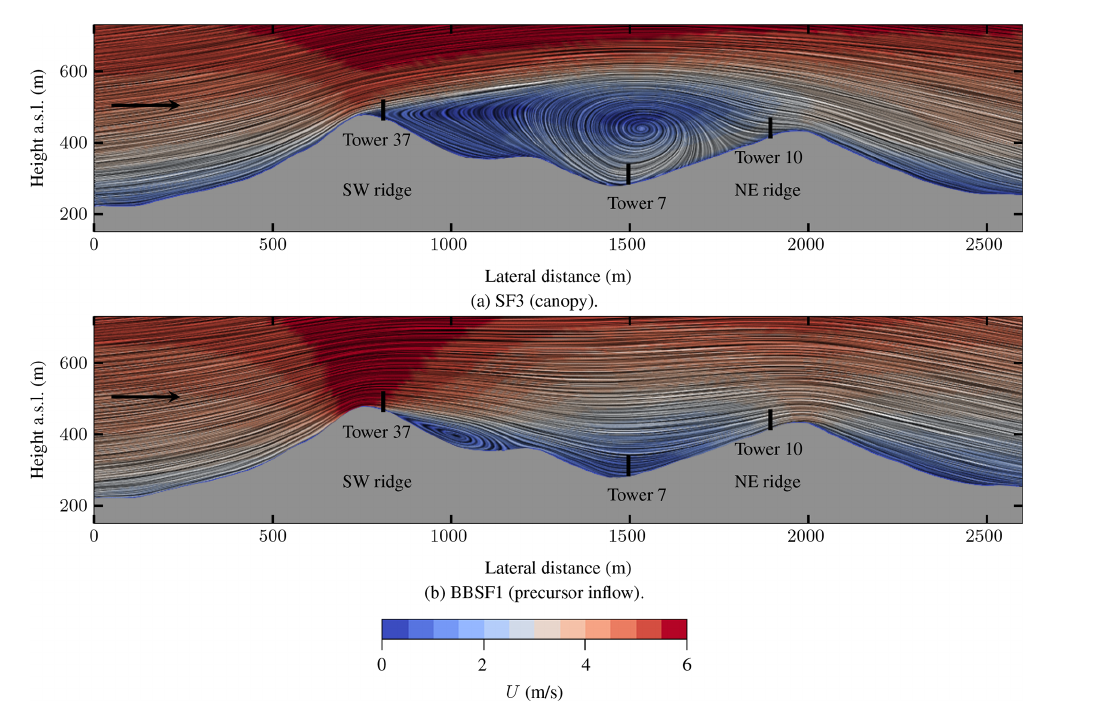
Figure 15. Vertical slice illustrating the recirculation zones inside the valley. Flow patterns and velocity magnitude, U , are visualized through the technique line integral convolution (LIC). The black lines represent the location and height of the nearest measurement towers in front of or behind the slice. The black arrows indicate the wind direction at the inlet, wind from SW at 231 ◦ , which is parallel to the orientation of the presented slice. The slice location and the locations of the masts are given in Fig. 2.